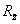
Determination of surface roughness.(A) Postprocessing of image stacks obtained by confocal laser scanning microscopy. (B) Measurement and calculation of surface roughness depth (Rz) for each slice. Rz~ represents the mean roughness depth for all slices.